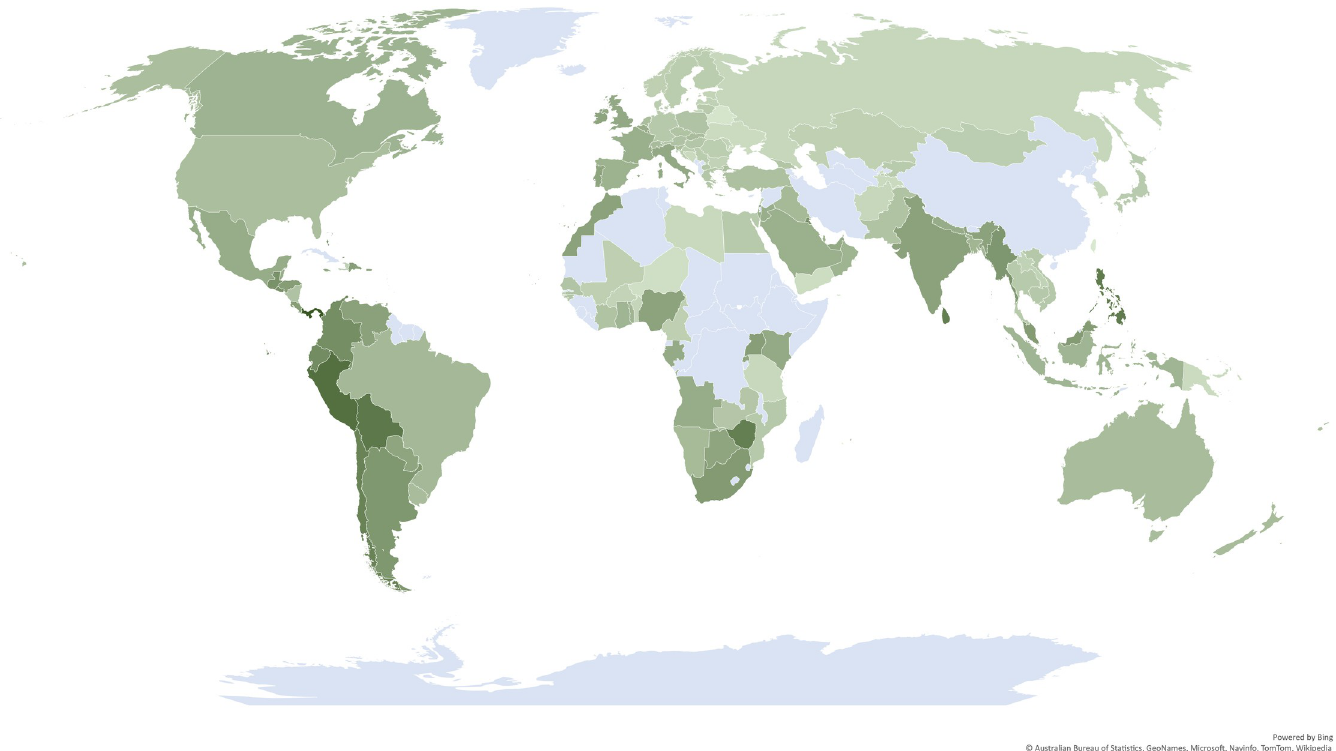
Fig 3. Social contact avoidance during the COVID-19 pandemic. Darker green colors signify countries with greater social contact avoidance during the COVID-19 pandemic. Lighter green colors stand for countries where social life went on more or less as usual. The measure used is the median plus one standard deviation of all residential mobility changes reported by Google for about 330 days from February 2020 to January 2021, against a baseline in January 2020. The data is available for 135 countries; no data is available for countries marked in light blue. (This is a chart created with Microsoft Excel 1 , based on data calculated by me in this present research; reproducing this map is thus considered to be fair